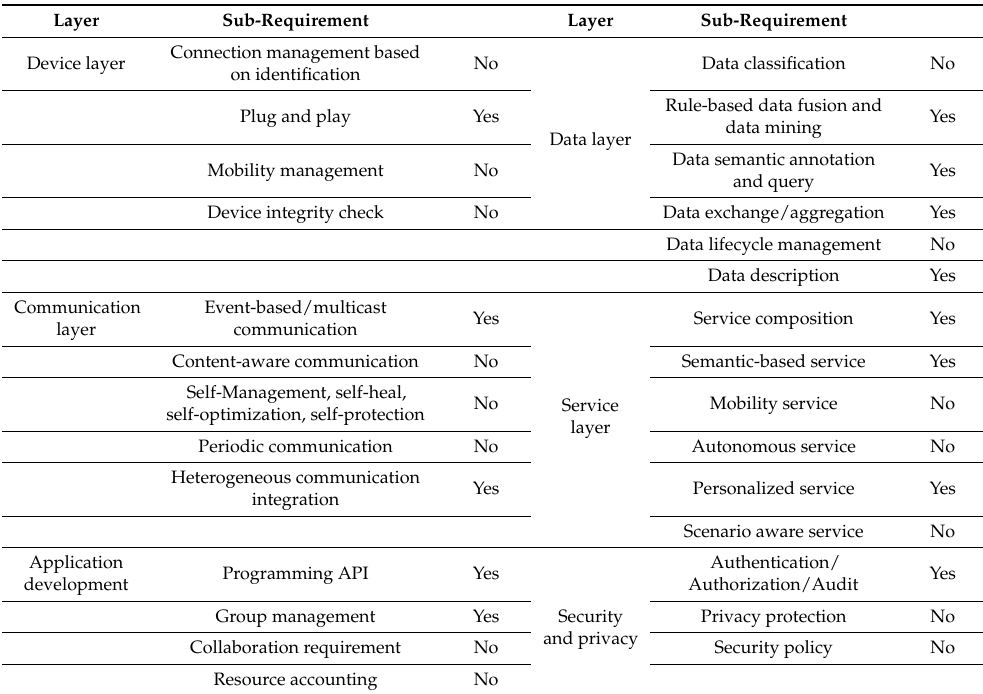
Table 4. Comparison between the IoT requirements and current open source